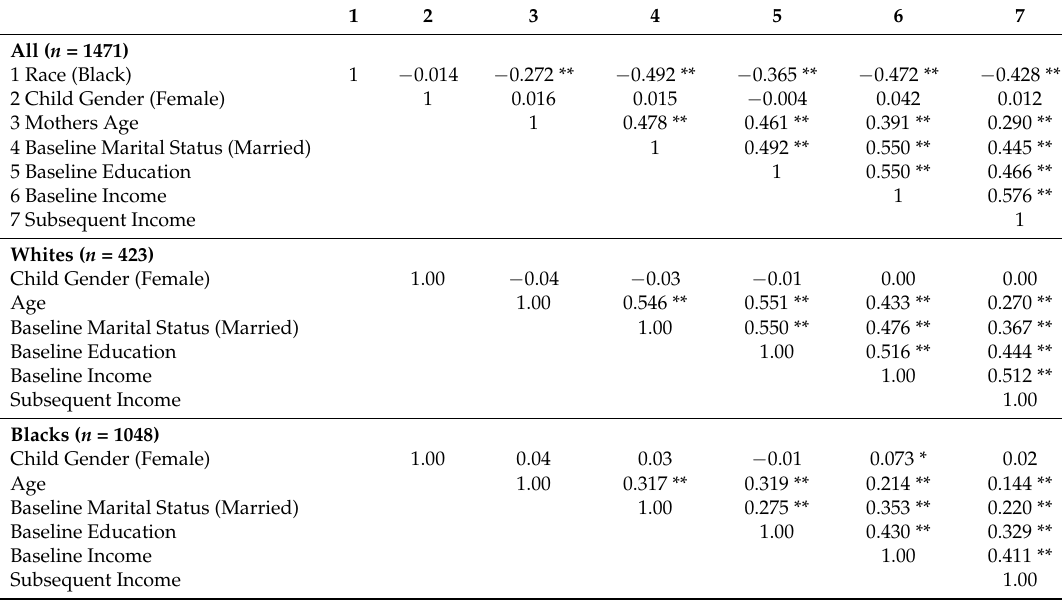
Table 2. Correlations in the pooled sample and by race.